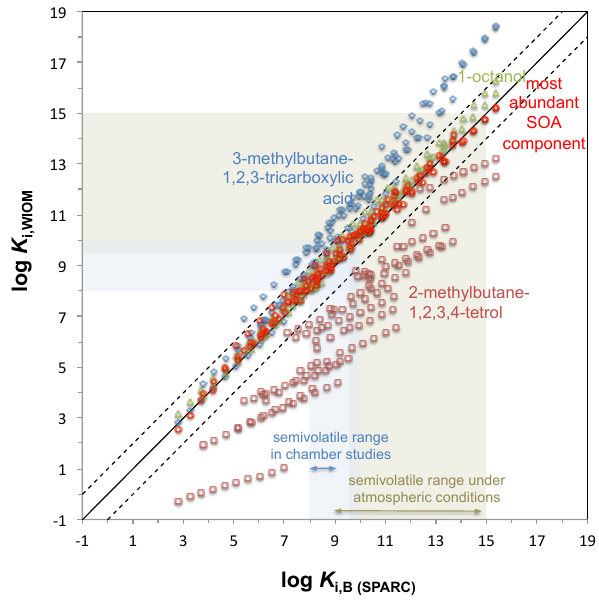
Figure 7. Plot comparing the partition coefficients at 25 ◦ C of alka- nes and their oxidation products between the water-insoluble or- ganic matter of aerosol and the gas phase predicted with COSMO- RS, using either the Kalberer et al. (2004) structure B as a surrogate solvent ( x -axis) or using a condensed phase with the actual com- position of SOA formed by the partitioning of the alkane oxidation products.